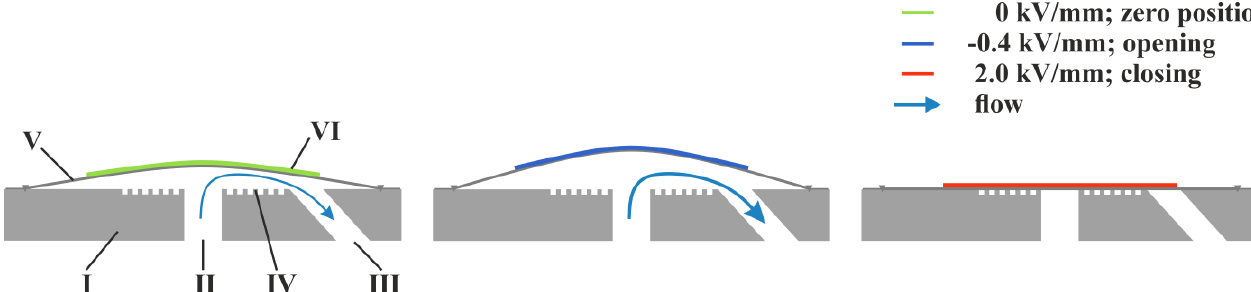
Figure 1. Working principle of the diaphragm-type piezoelectric NO valve. In non-actuated state, the valve is open and allows for fluid flow. By piezoelectric actuation, a negative electric field opens the valve further, resulting in reduced fluidic resistance, and a high positive field closes the fluid path by exerting a high contact pressure on the valve seat.